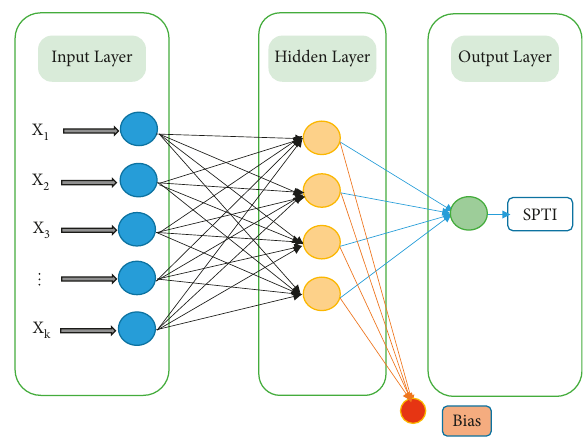
Figure 2: The topological structure of the extreme learning ma- chine network. The input layer is the lag values of SPTI, the hidden layer contains randomly assigned hidden nodes, and the output layer generates predicted values of